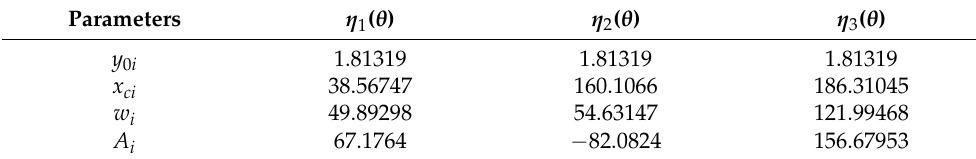
Table 4. Fitting parameter values of Equation (13).